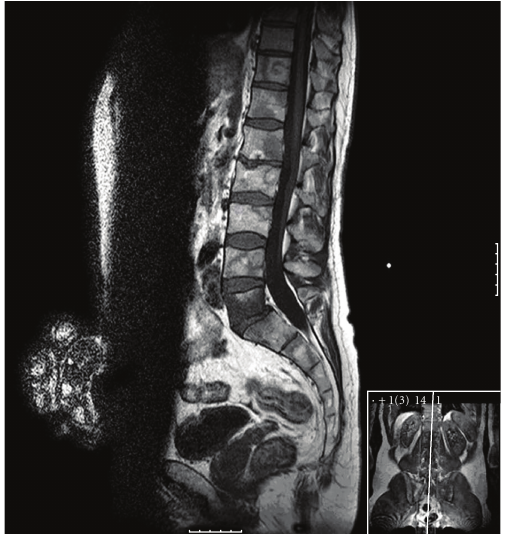
Figure 3: There is di ff use involvement of multiple vertebrae including L5 seen throughout the spine on T1-weighted imaging with both low and high signal.